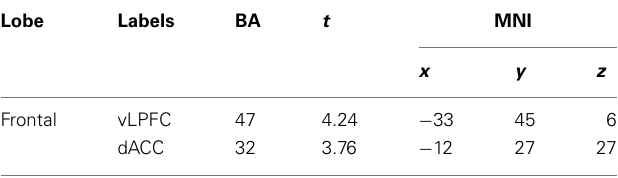
Table 3 | List of regions showing a correlation with the